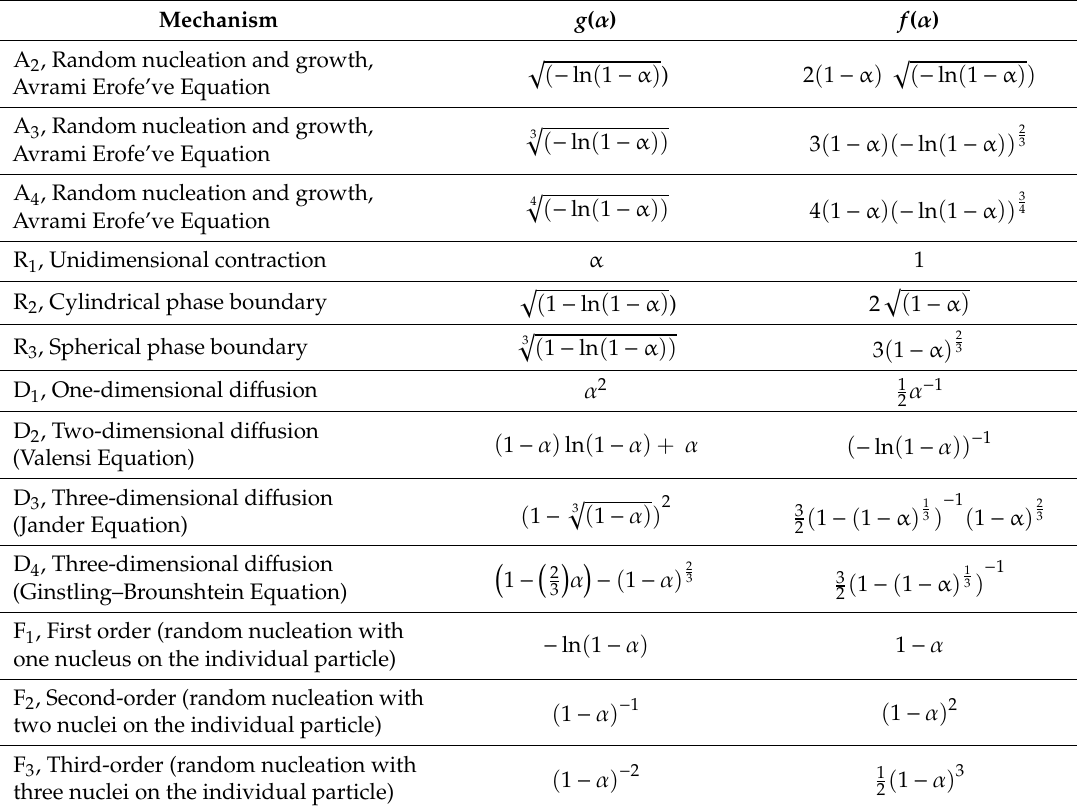
Table 1. Algebraic expressions of g ( α ) and f ( α ) for the kinetic mechanisms of the Coats–Redfern (CR) model used